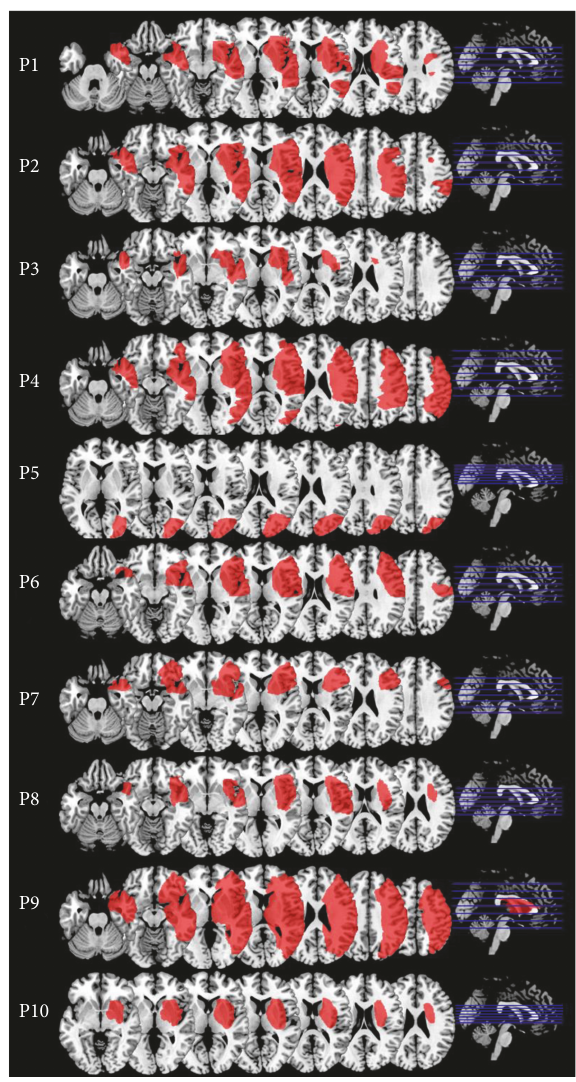
Figure 1: Lesions of individual patients displayed on axial slices of a normalized MRI template (positions of the slices in